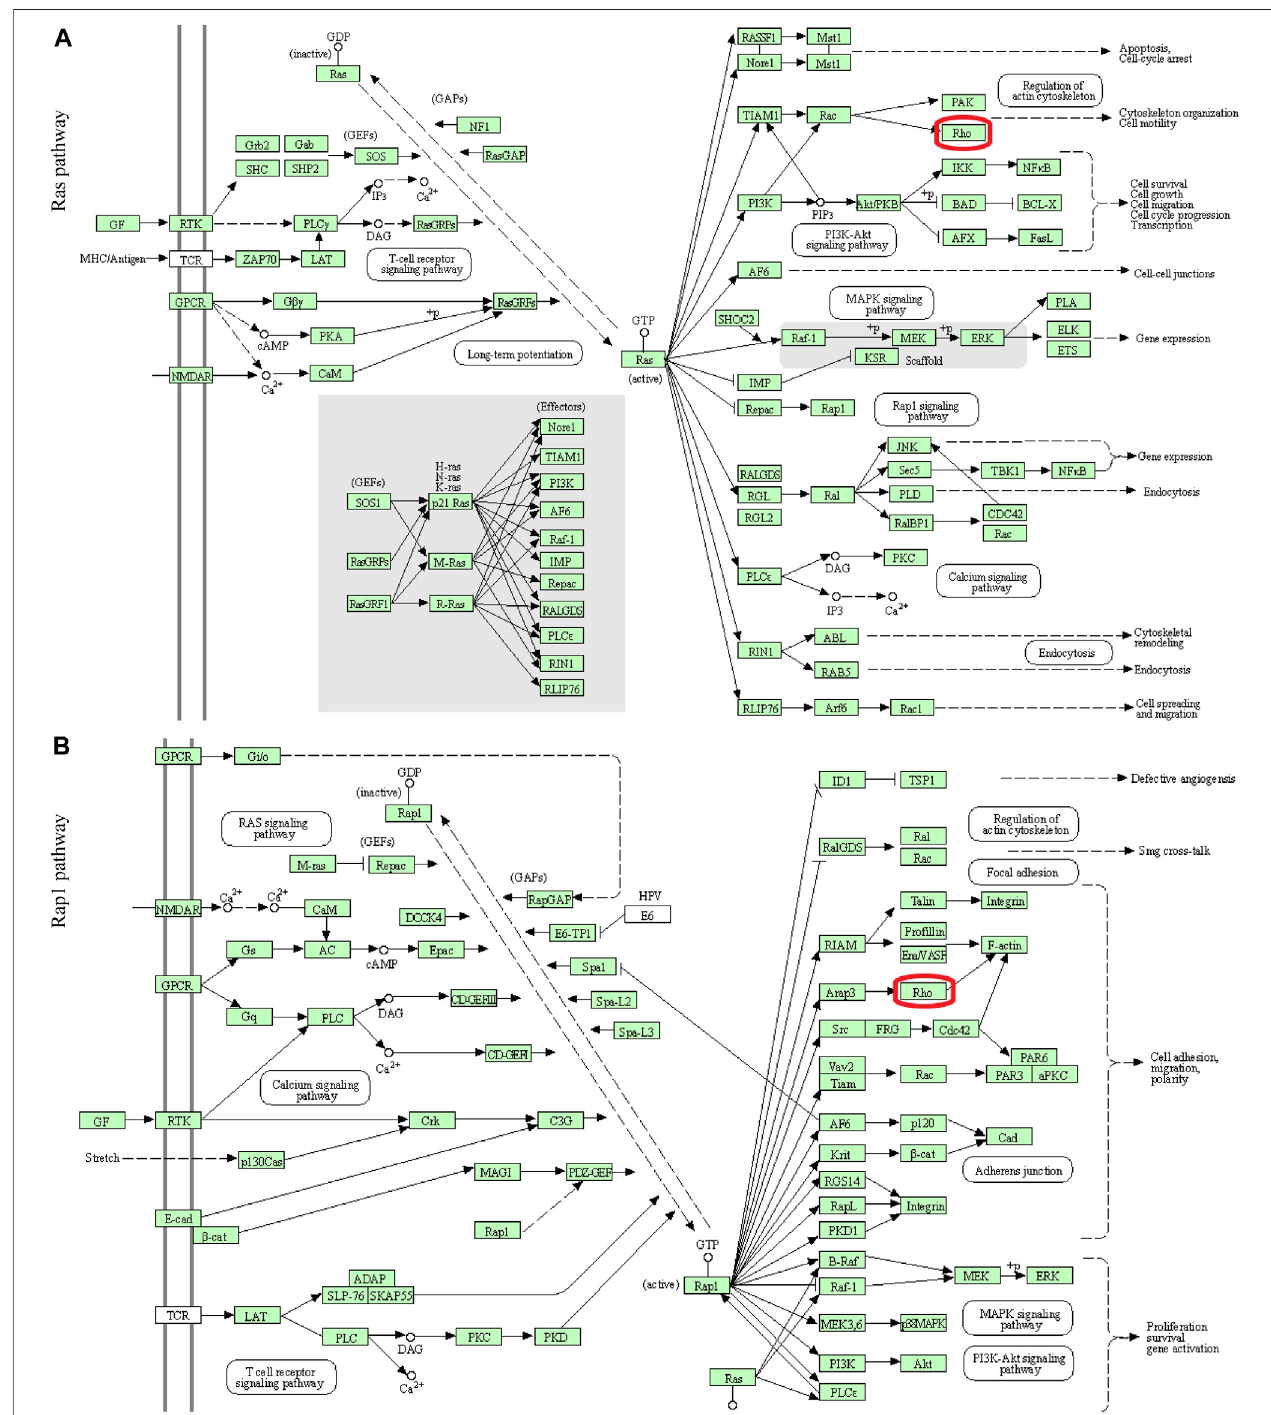
FIGURE 4 | Visualization of the Ras and Rap1 pathways (A) The Ras pathway (B) The Rap1 pathway. The red box indicated that these two signaling pathways passed through Rho.